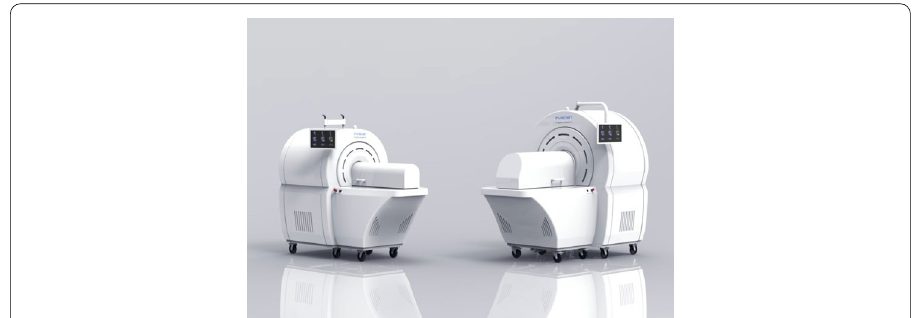
Fig. 1 Photographs of the IRIS PET/CT (on the left‑end side) and the IRIS XL‑220 PET/CT (on the right‑end side) systems at the core facility for preclinical imaging of the University of Tours (Département d’Imagerie Préclinique, Plateforme Scientifique et Technique Analyse des Systèmes Biologiques, Université de Tours, Tours,